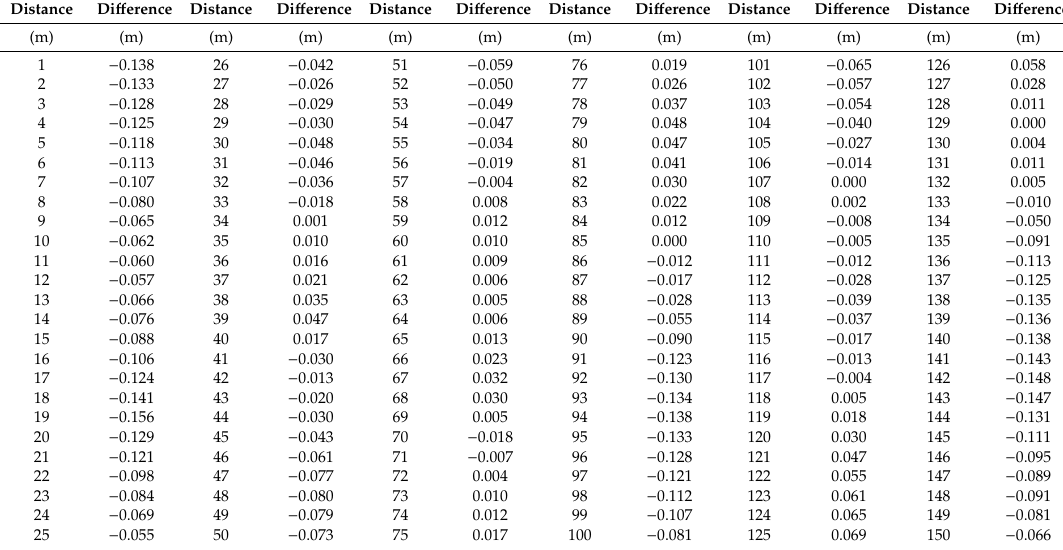
Table 1. Numerical values for each distance to the origin of the profile of Figure 10, expressed in terms of the di ff erence (m) between the predictive data and those obtained in the field for the year